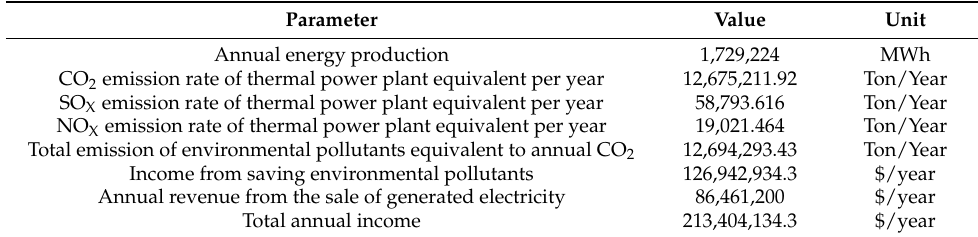
Table 1. Income specifications of this